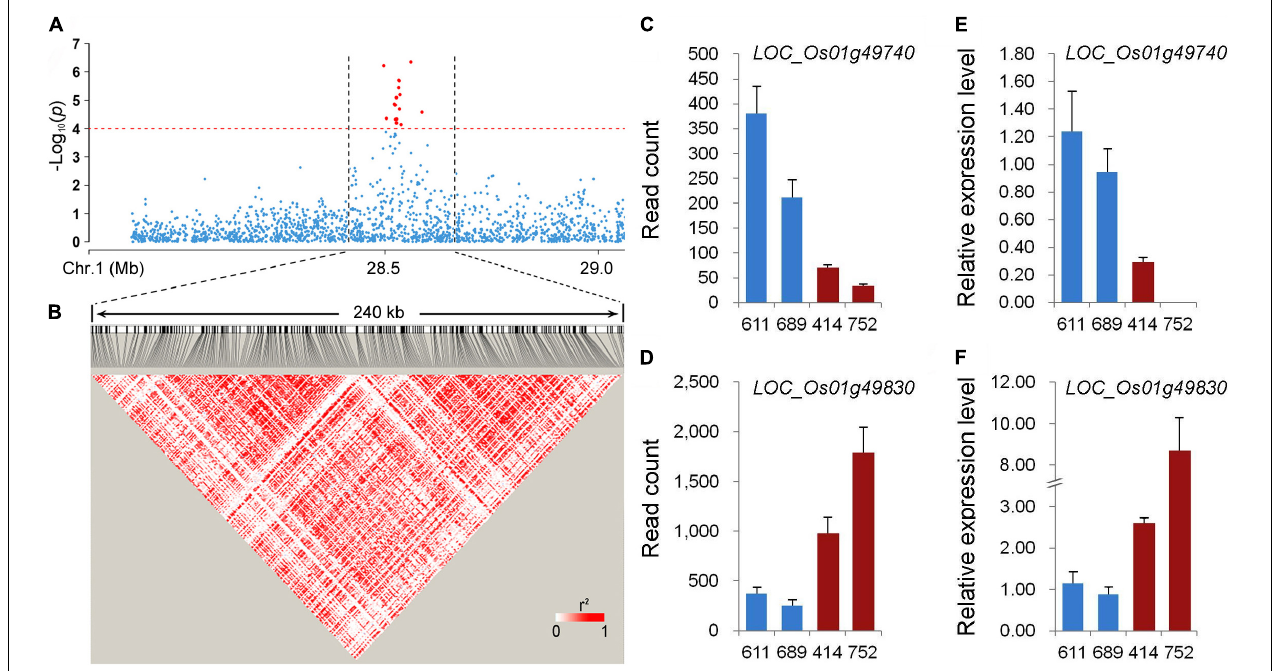
FIGURE 3 | Candidate gene analysis of qPC-1 . (A) Local Manhattan plot of GWAS for qPC-1. (B) Linkage disequilibrium (LD) heatmap around the peak. (C,E) The expression of LOC_Os01g49740 in lines with white pericarp (accessions 611 and 689) and red pericarp (accessions 414 and 752) measured using RNA-seq and qRT-PCR, respectively. (D,F) The expression of LOC_Os01g49830 in lines with white and red pericarp measured using RNA-seq and qRT-PCR,